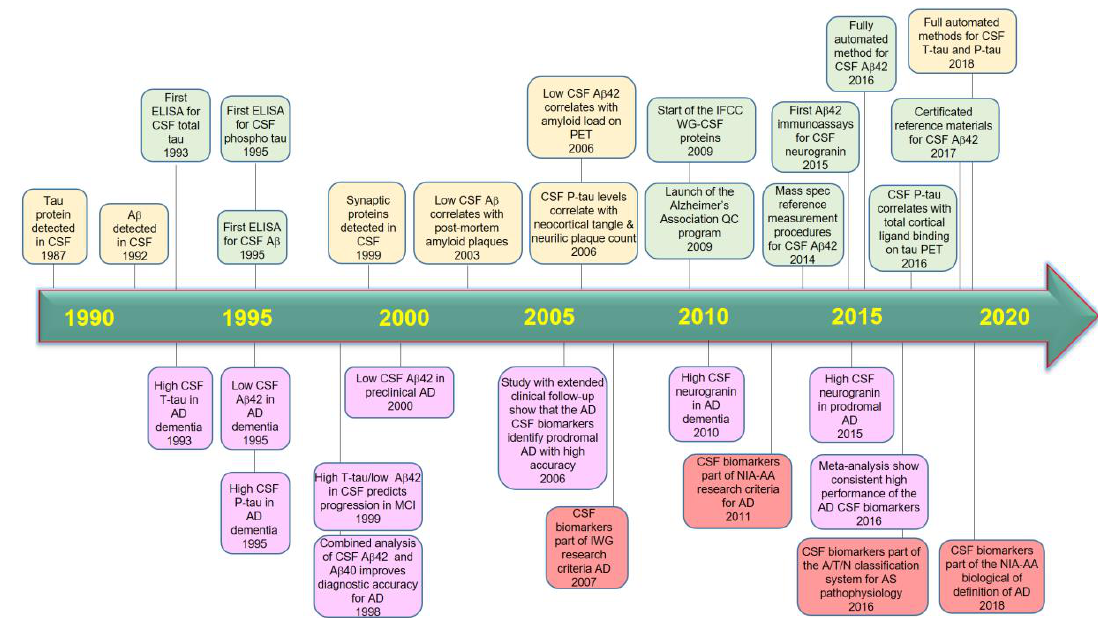
Figure 1. A timeline reflecting the evolution of the body fluid Alzheimer’s disease biomarkers. Green boxes, technical developments; yellow boxes, pathophysiological findings; purple boxes, clinical findings; brown boxes, evolution of clinical diagnostic criteria and pathogenic classifications. A β , amyloid beta; AD, Alzheimer’s disease; CSF, cerebrospinal fluid; MCI, mild cognitive impairment; N, neurodegeneration.